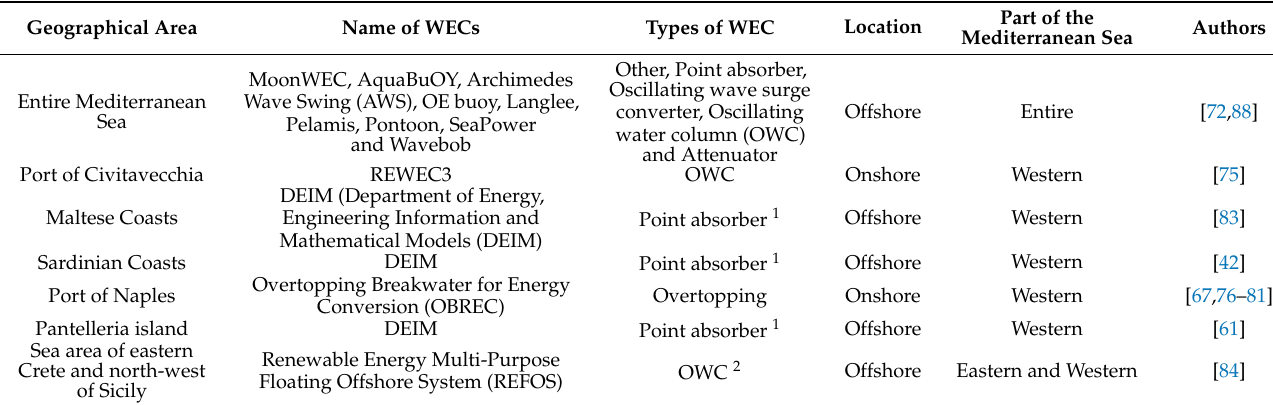
Table 5. Academic research on specific WECs.